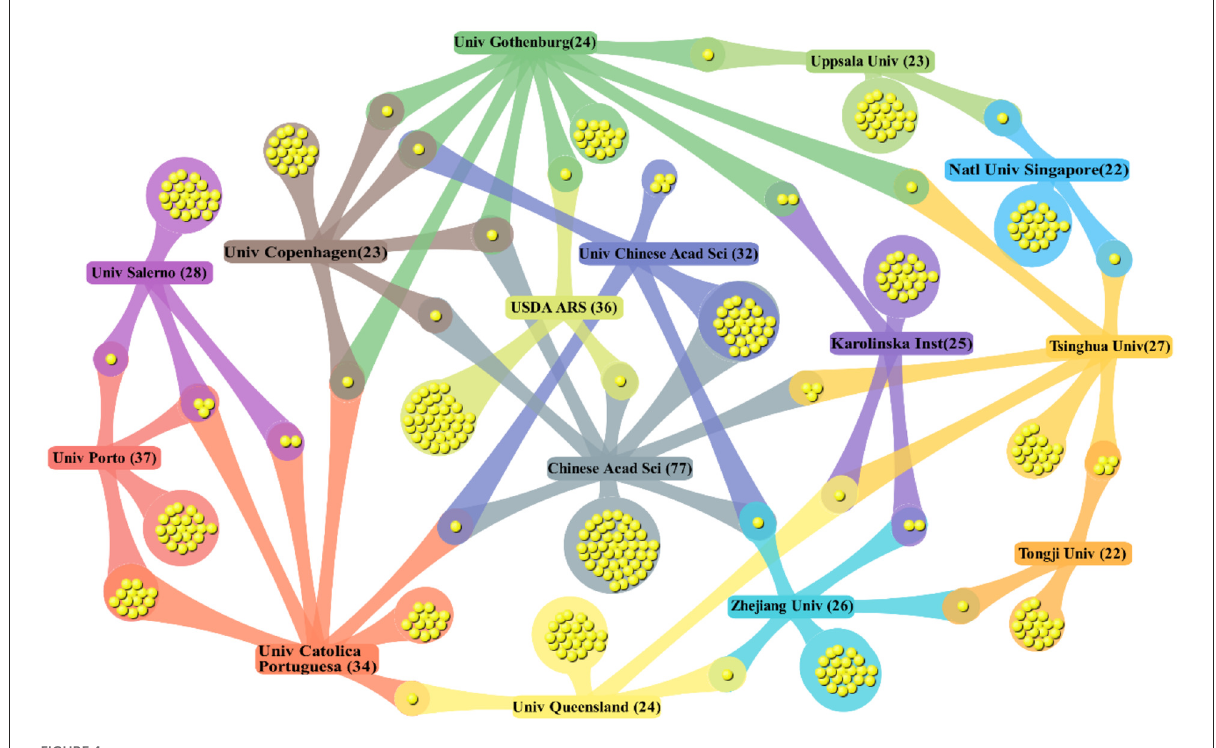
FIGURE4 DDA cluster map on cooperation of the top 15